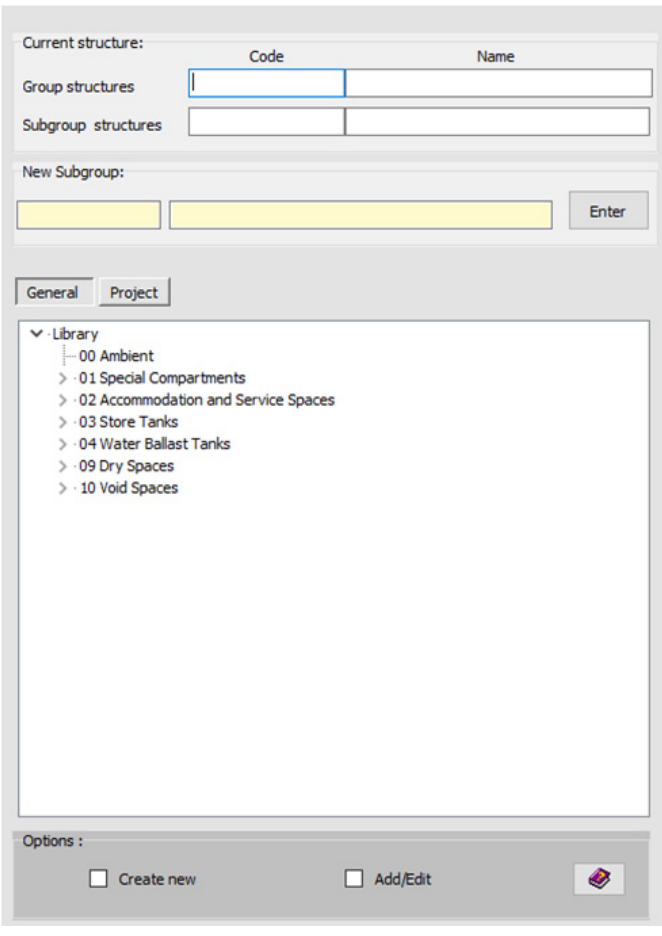
Table 2. Subgroups and groups of ship